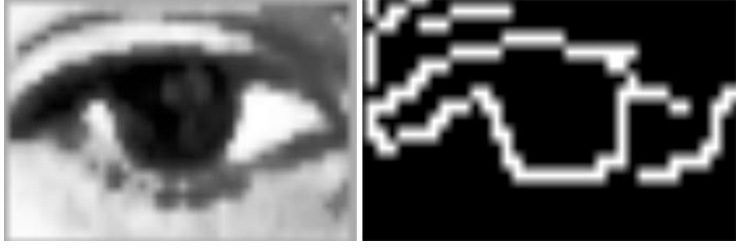
Figure 10. Eye region of